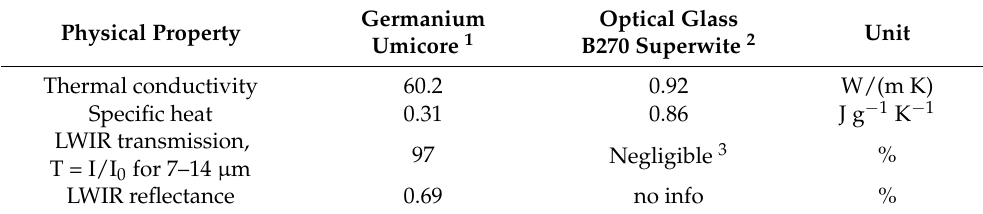
Table 1. Physical properties of germanium (HEAR/HEAR coated) and Schott B 270 superwite modified soda-lime glass used in the